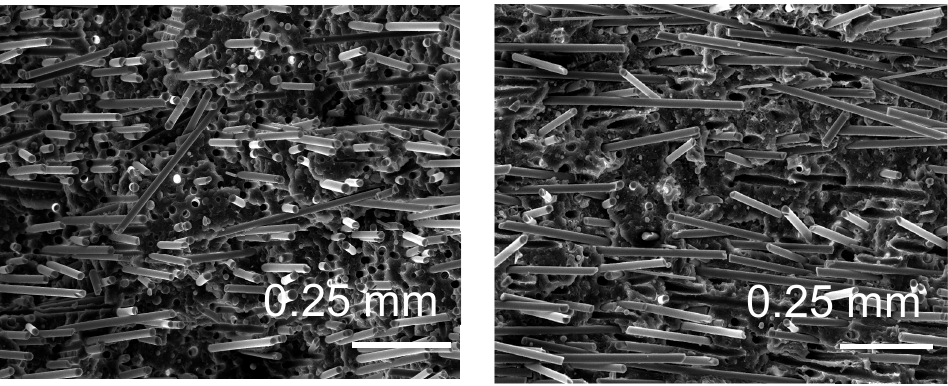
Figure 11. Effect of fiber orientation for 30 W f %, i.e., Perpendicular vs. Parallel fibers to the loading direction. In total, 30% W f is 50% recyclate and 30% perpendicular regrind sample has more fiber aligned in the loading direction and fibers aligned out of plane from the screen and 30% Parallel samples have fibers aligned in-plane to the screen.